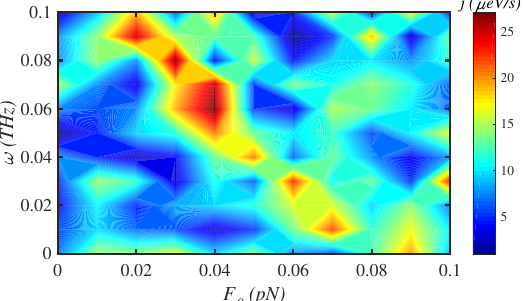
Figure 7. The energy flux j map through a N = 150 site protein chain under the influence of both the magnitude F 0 and the frequency ω of the external mechanical force at T = 300 K.